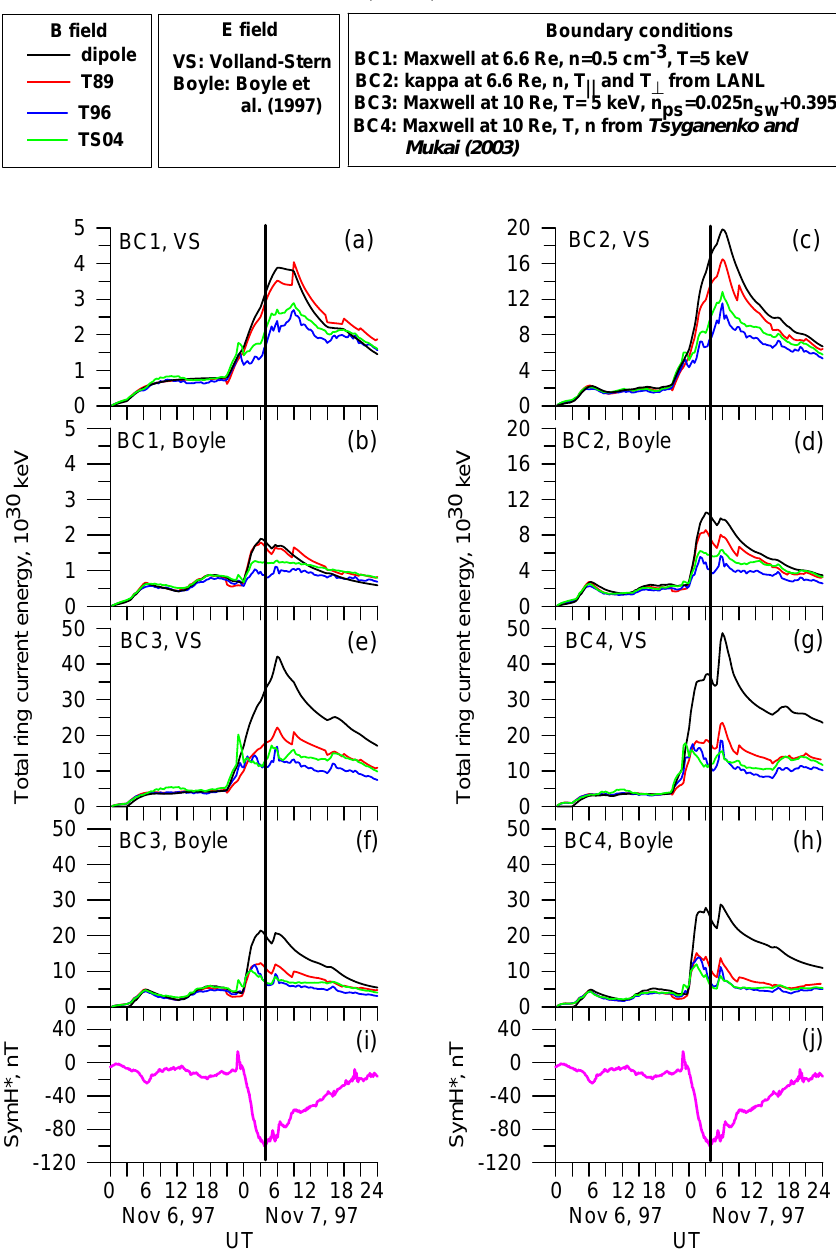
Fig. 2. Modeled proton (1–300keV) ring current energy content during the 6–7 November 1997 storm with initially empty magnetosphere for combinations of four boundary conditions, two electric and four magnetic field representations. The corrected SymH* index is shown by thick purple lines. Thick black vertical lines mark the time moment of minimum in SymH* index through all figures. Note the scale differences on the